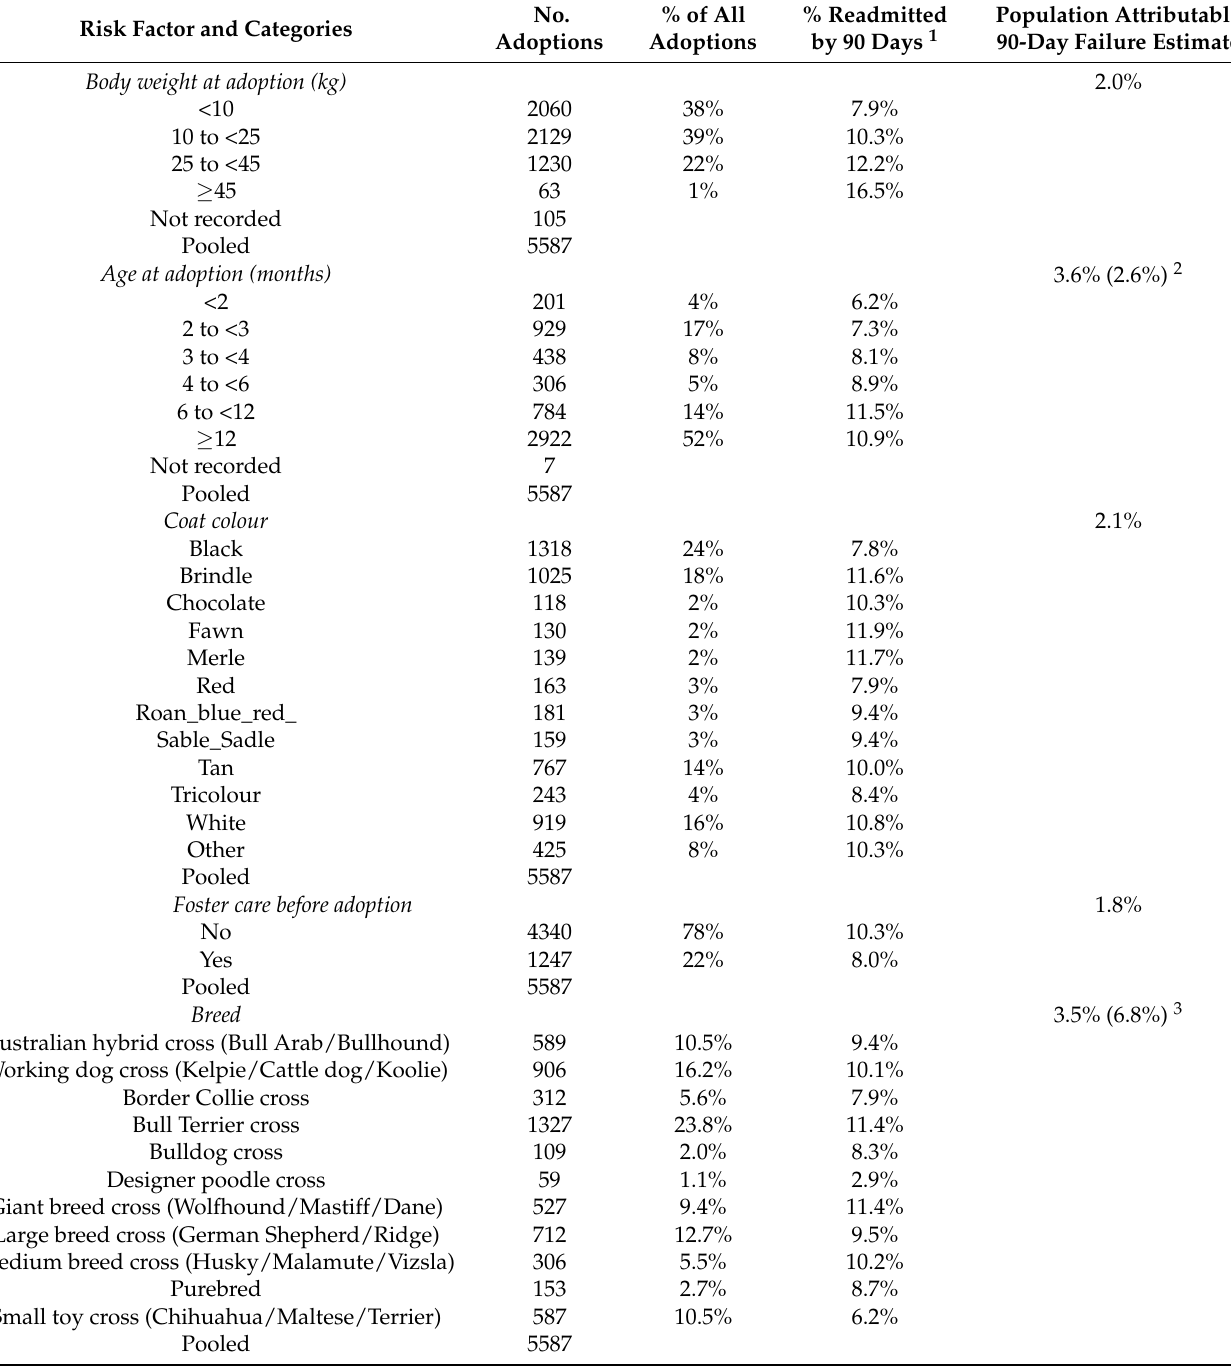
Table 7. Population attributable 90-day failure estimates for risk factors for readmission to RSPCA Queensland of dogs adopted from RSPCA Queensland in 2019 and